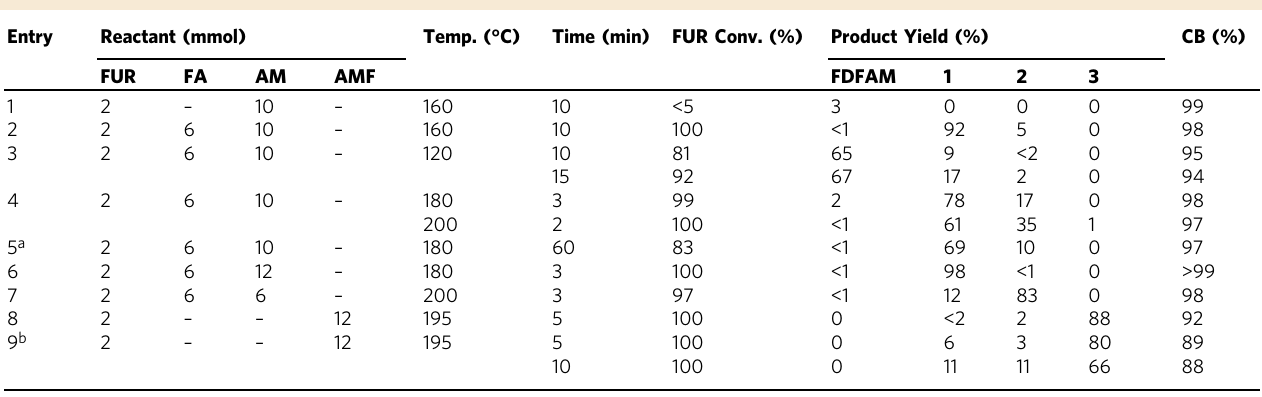
Table 1 Microwave-assisted amination of furfural (FUR)